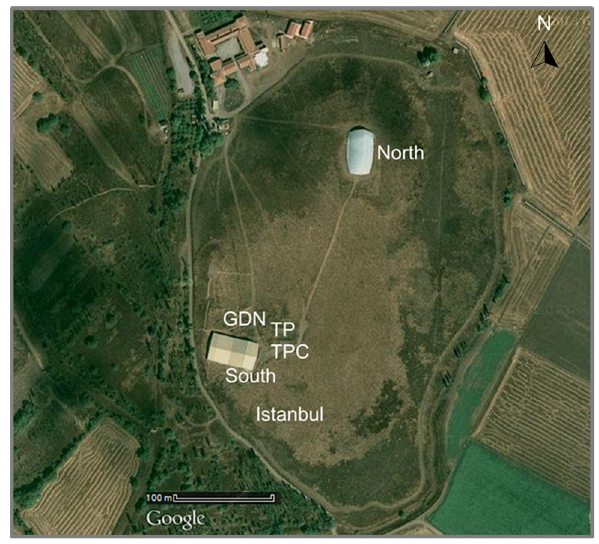
Figure 2: Map of the site with details of the excavation area. Abbreviations refer to the excavation areas. TP ( Team Pozna ń ) and South Areas are discussed here. Source: Google Earth, with modi fi